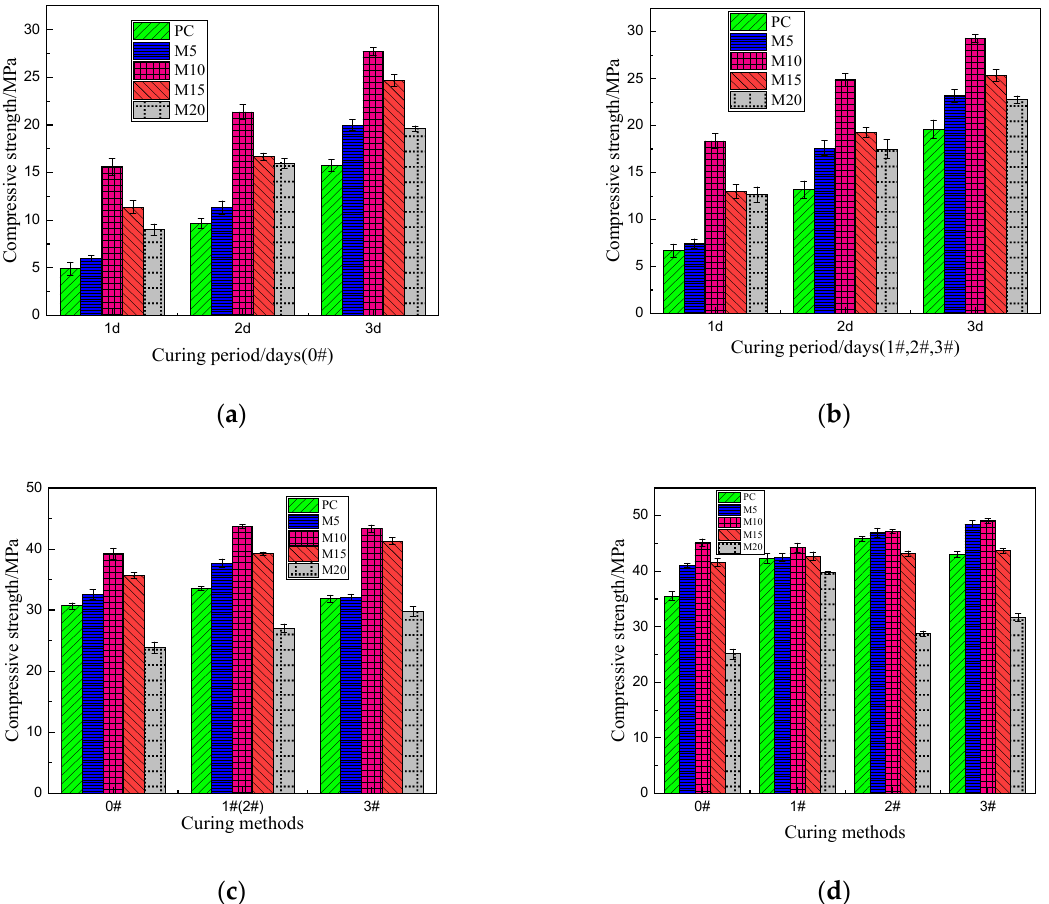
Figure 2. The compressive strength of cement after aging for 1, 2, 3, 7 and 28 days under different curing methods; ( a ) 1, 2, 3 days of 0#, ( b ) 1, 2, 3 days of 1#, 2# and 3#, ( c ) 7 days of 0#, 1#, 2# and 3#, ( d ) 28 days of 0#, 1#, 2# and 3#.